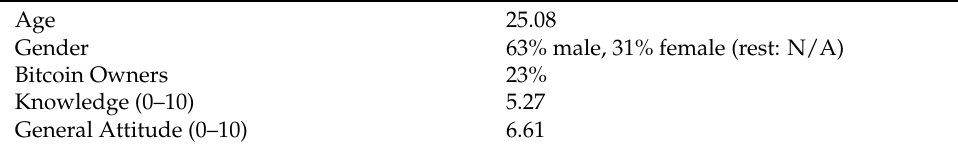
Table 1. Sample characteristics ( n =